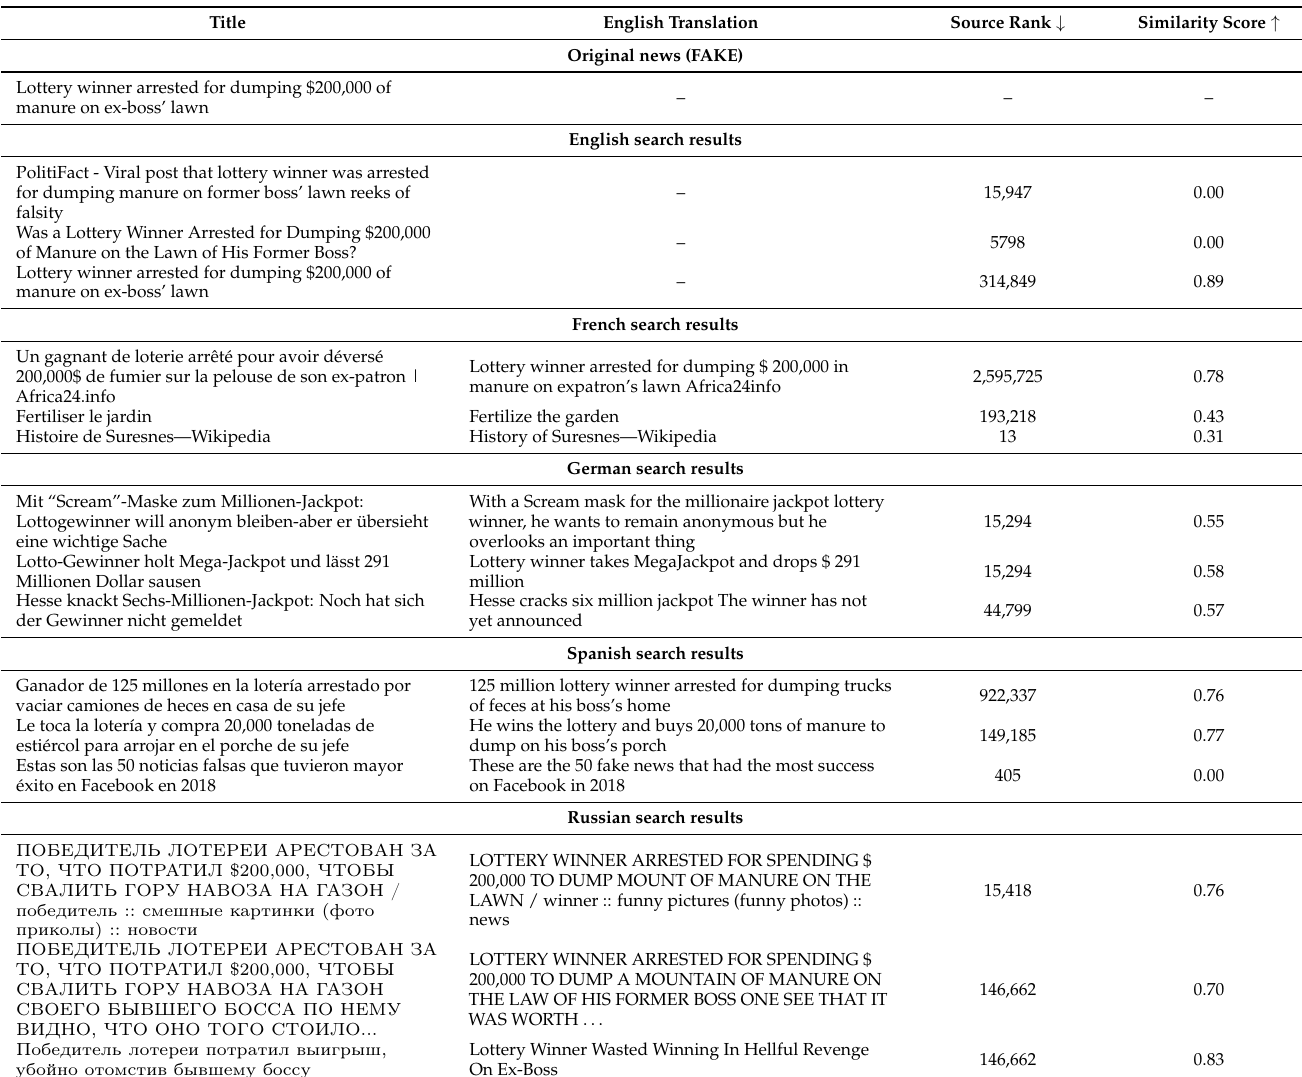
Table A1. The example of work of the proposed approach for fake and legit news. For each target language (English, French, German, Spanish, Russian), the search results are presented: titles of the top three news items. For every non-English title, the English translation is provided. Each piece of scraped news is rated with the rank of its source and content similarity to the original news based on text embedding. The larger (or the lower ) the score, the better. For fake news , the search results ↑ ↓ either come from unreliable sources or provide no relevant information to the original news. English Translation Source Rank Similarity Score ↓ ↑ Original news